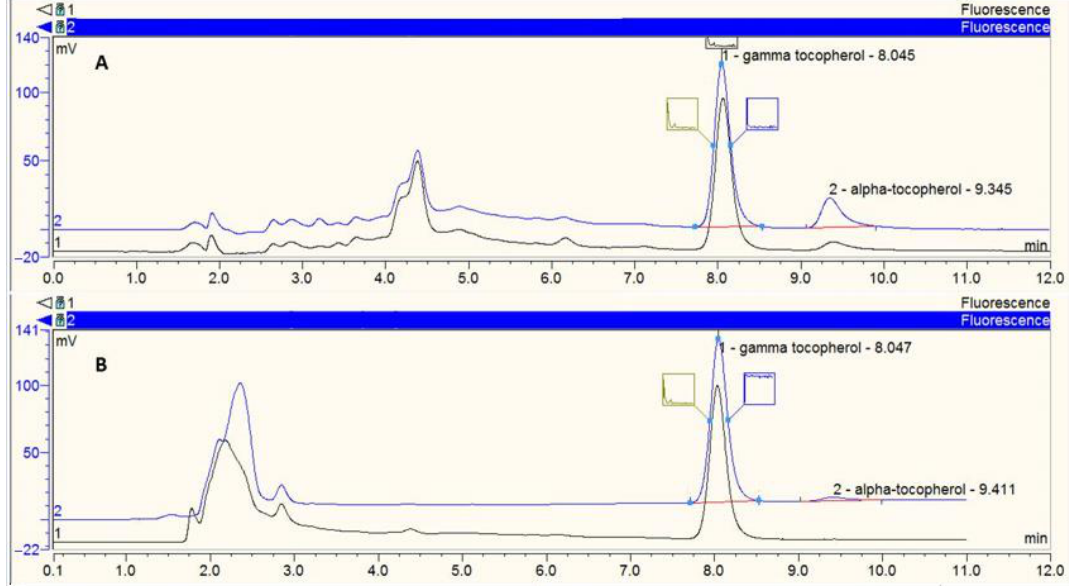
Figure 2. Example of chromatogram. ( A ) The upper part of the figure represents the chromatogram after analysis of the basolateral compartment under the condition with saponification (=hydrolysis of esterified tocopherol). The conditions at 3 h (h3) are shown in black and the conditions at 24 h (h24) are in blue on the same chromatogram. ( B ) The lower part of the figure represents the chromatogram after analysis of the basolateral compartment under the condition without saponification (=free tocopherol). The conditions at h3 are shown in black and the conditions at h24 are in blue on the same chromatogram. γ -tocopherol was used as an internal standard. The red lines represent the baselines of the chromatography peaks.